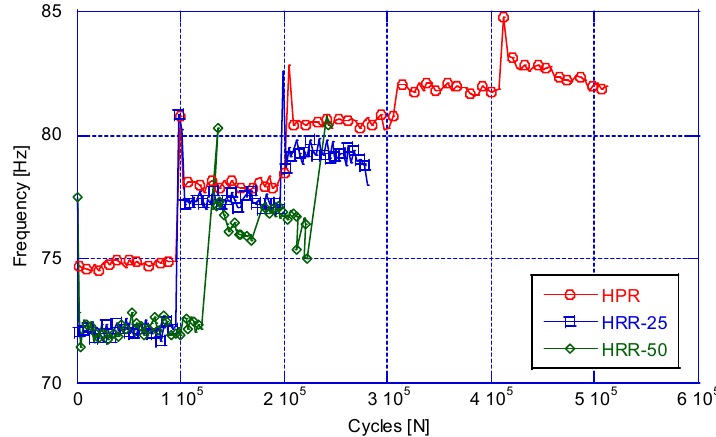
Figure 8. Resonance fatigue frequency evolution during a Locati test for OPC mixes.